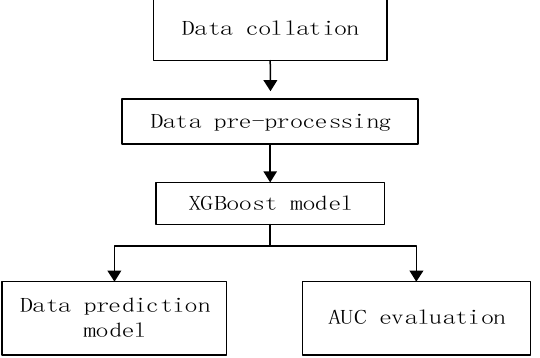
Figure 1.XGBoost prediction model flow